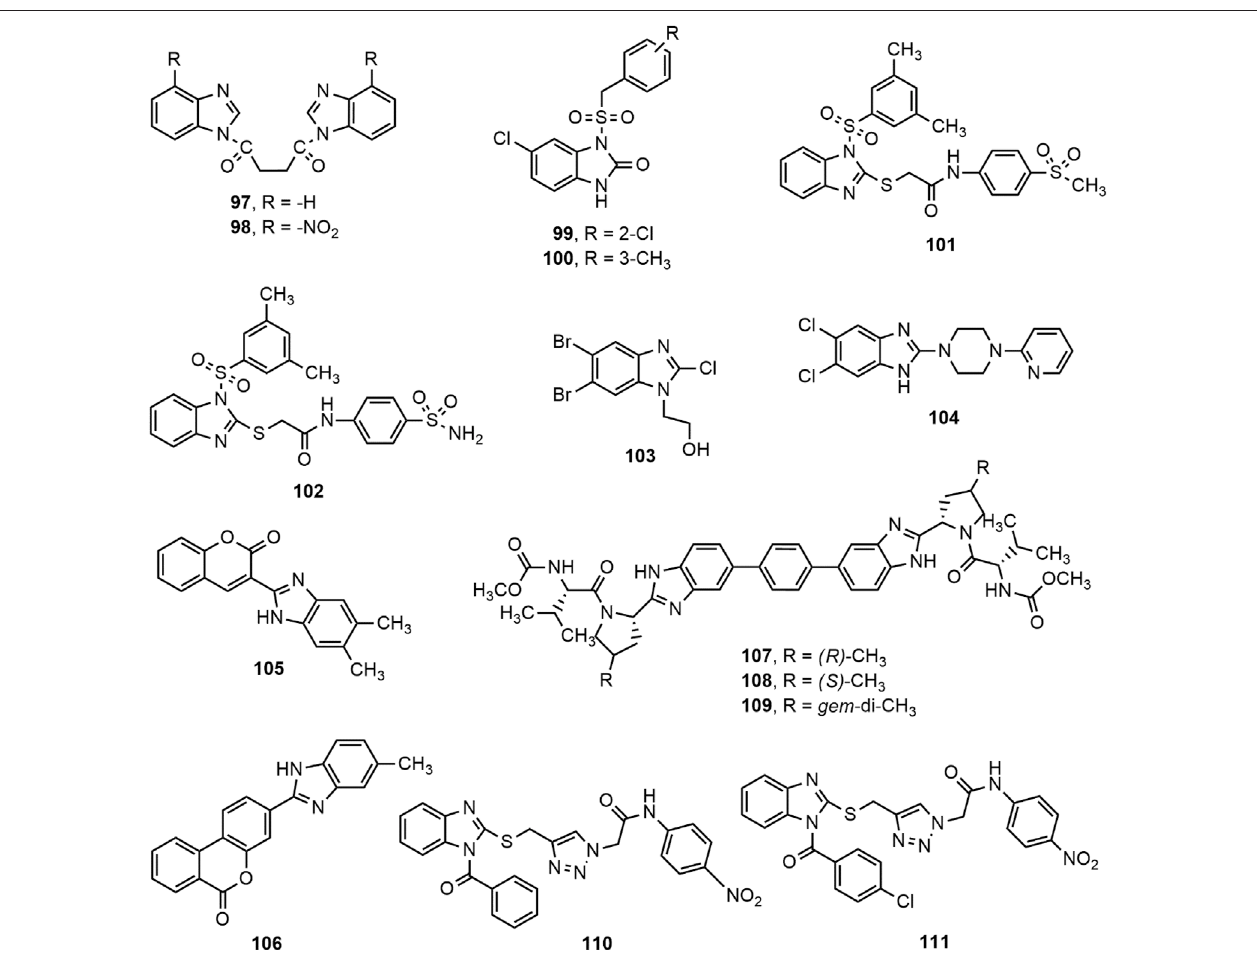
FIGURE 4 | Benzimidazole derivatives with antiviral